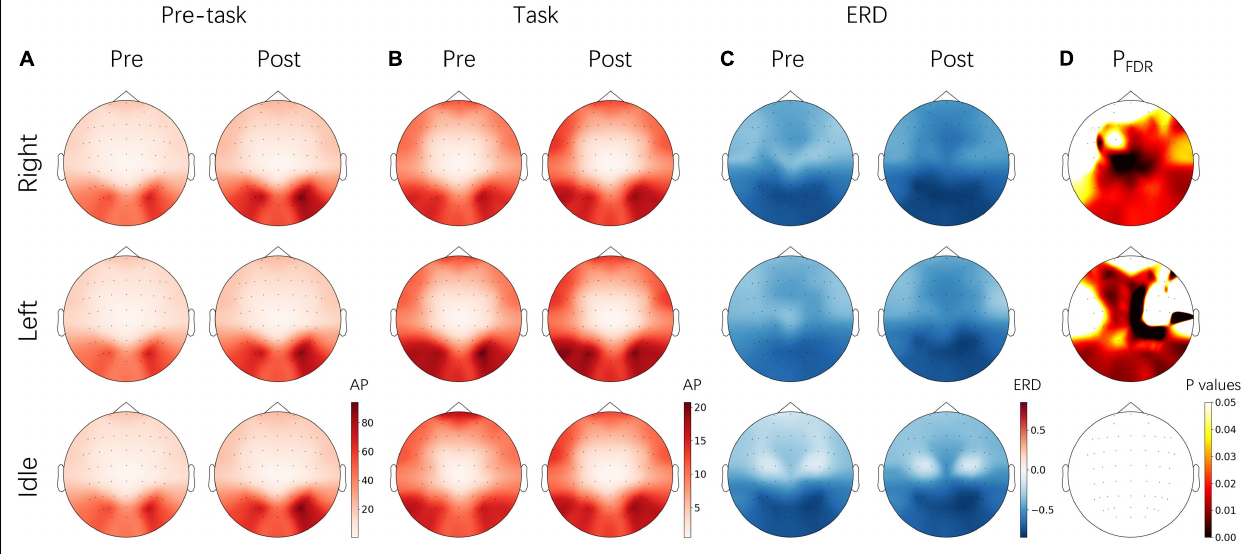
Frontiers in Human Neuroscience |